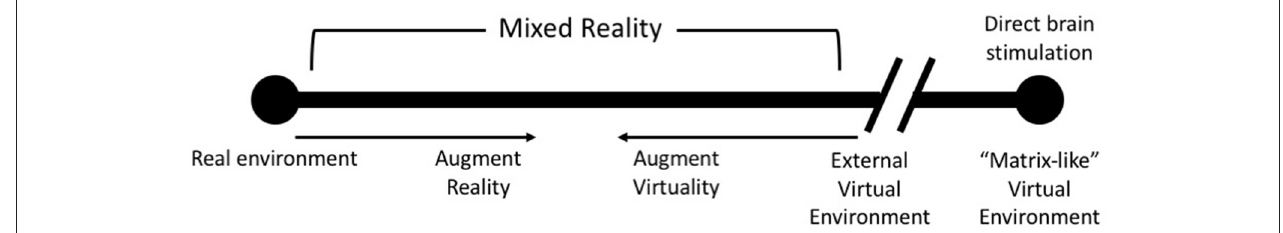
FIGURE 2 | An update of Milgram’s Reality-Virtuality Continuum (150) proposed by Skarbez et al. (151) [image redrawn and modified from Skarbez et al. (151), Figure 2, page